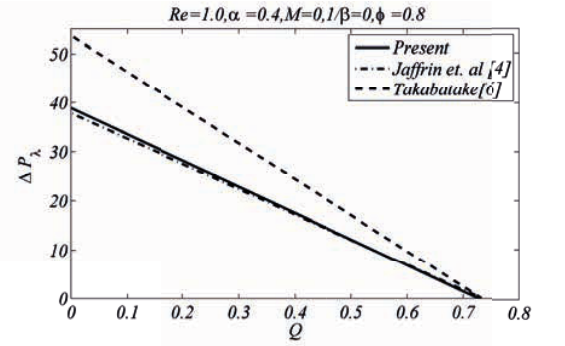
Fig. 3: Comparison of pressure profile based on our results of the sinusoidal waveform with Jaffrin [4] and Takabatake